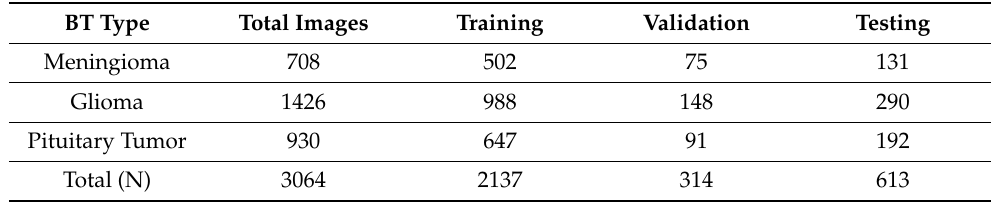
Table 1. Figshare dataset showing the number of MRI slices for each tumor category. MRI: magnetic resonance imaging, BT: brain tumor, N: number of images. BT Type